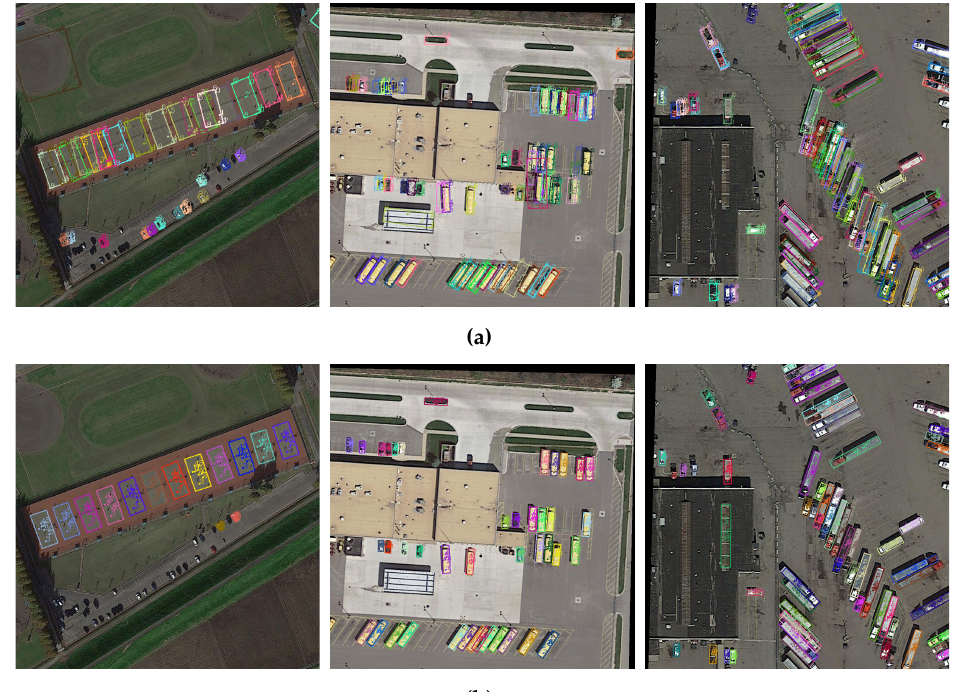
Figure 5. Comparison of the visualization results of PointSet and G-Rep on the DOTA dataset.